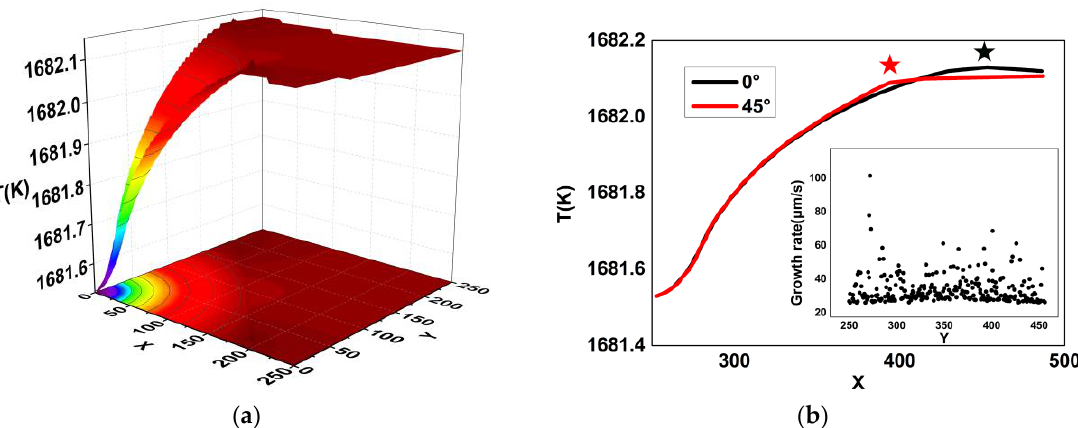
Figure 4. Simulation results of temperature: ( a ) entire simulation area; ( b ) normal direction of 0° and